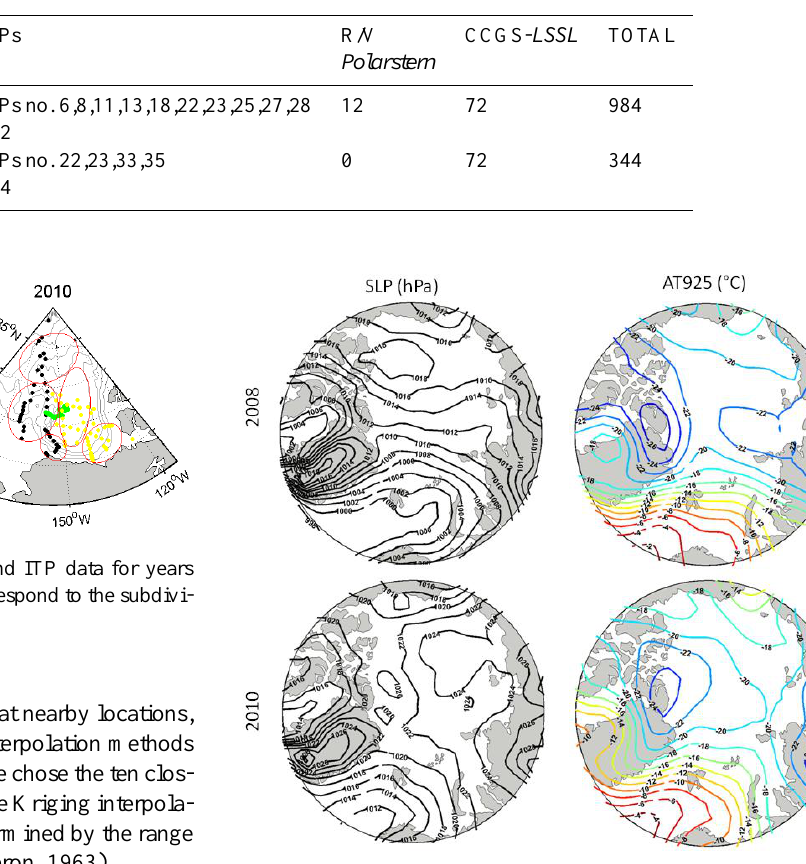
Fig. 4. Mean wintertime (December–January–February) SLP (left) Figure 4: Mean wintertime (December-January-February) SLP (left) in hPa, and temperature at 925 hPa (right) in degrees Celsius, both in 2008 (top) and 2010 (bottom). in hPa, and temperature at 925hPa (right) in degrees Celsius, both in 2008 (top) and 2010